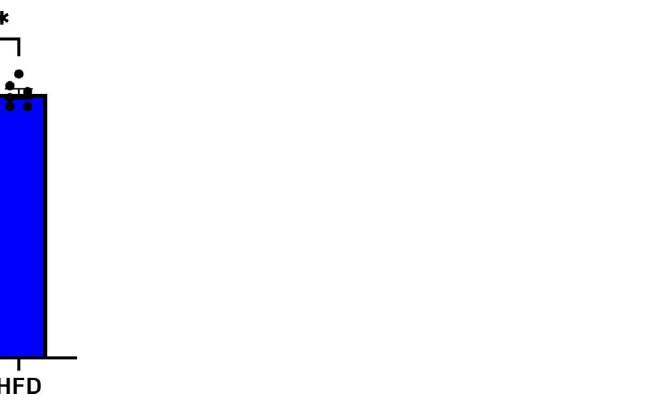
Figure 9. Histological evaluation of hepatic steatosis. Differences in hepatic steatosis (%) between NPD and HFD groups. **** for p < 0.0001.